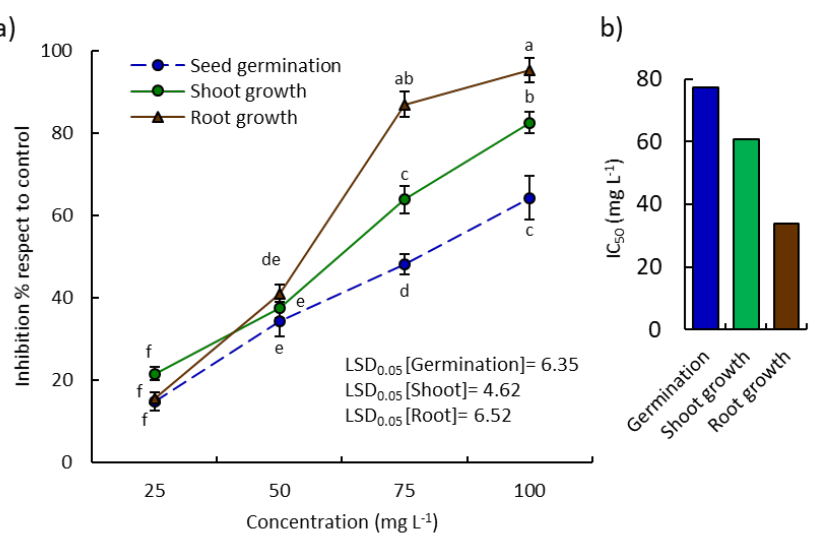
Figure 2. Allelopathic activity of the Persicaria lapathifolia essential oil. ( a ) Inhibitory effect on the germination, seedling root, and shoot growth of the weed Echinochloa colona ; ( b ) IC 50 values. Different letters mean a significant difference in values after Tukey’s HSD test ( p < 0.05).